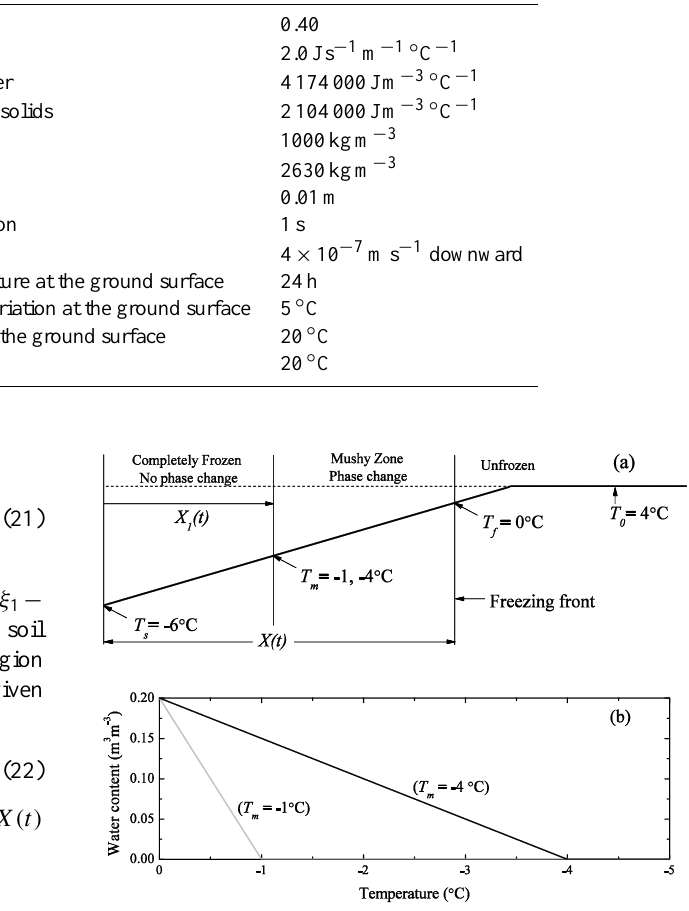
Figure 6 (a) Diagram showing the setting of Lunardini (1985) three zone problem. Equations 18, 19, and 20 are used to predict temperatures in completely frozen zone (no phase change and sensible heat only), mushy zone (phase change and latent heat + sensible heat), and unfrozen zone (sensible heat only) respectively. (b) Linear freezing function used to predict unfrozen water contents for two cases used in this study ( T m = -1°C and T m = -4°C).